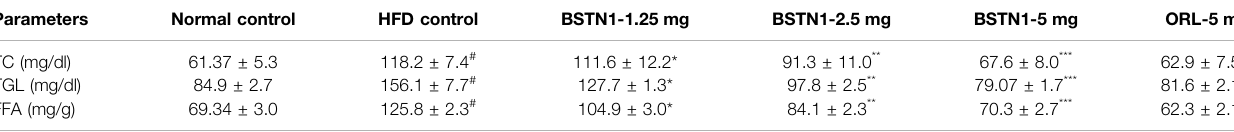
TABLE 3 | Effect of BSTN1 on hepatic lipid pro fi le of treated and untreated rats. Parameters